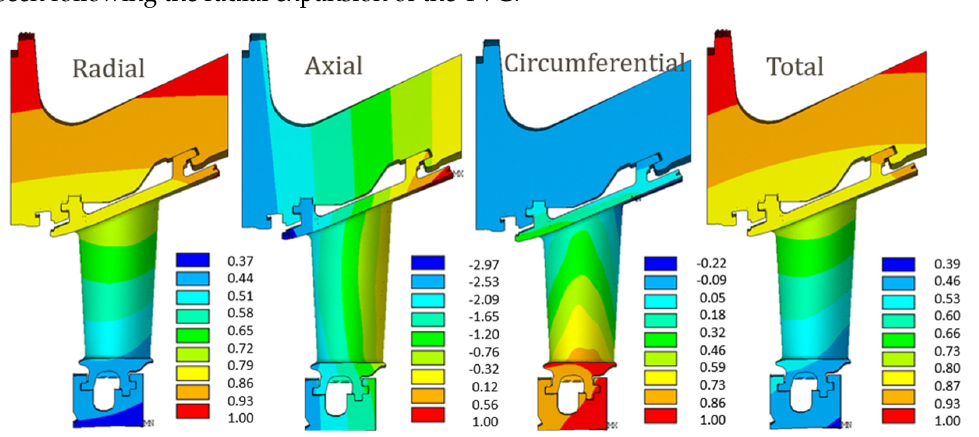
Figure 14. Distribution of the normalized displacements (with respect to the maximum displacement) on the vane.